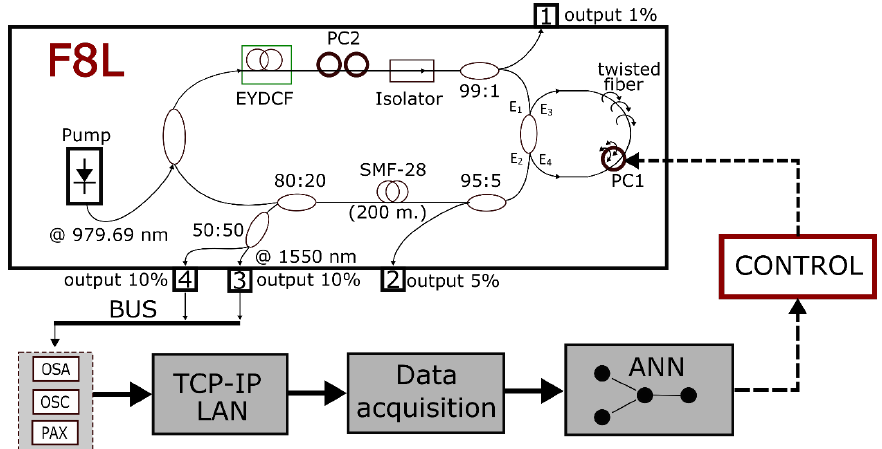
Figure 1. F8L experimental scheme for automated data acquisition remotely.